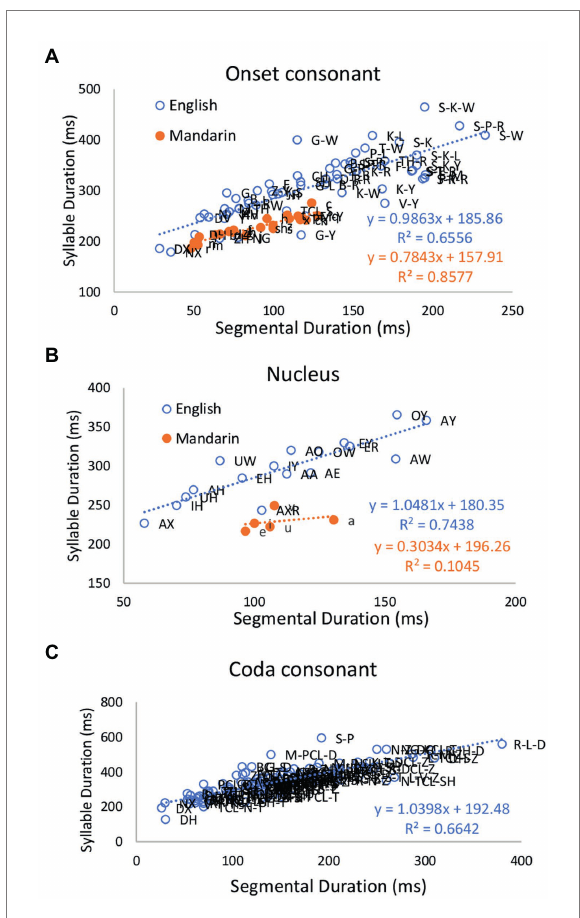
FIGURE 3 Effects of consonant (A) and (C) and vowel (B) identity on CVC syllable duration in American English and